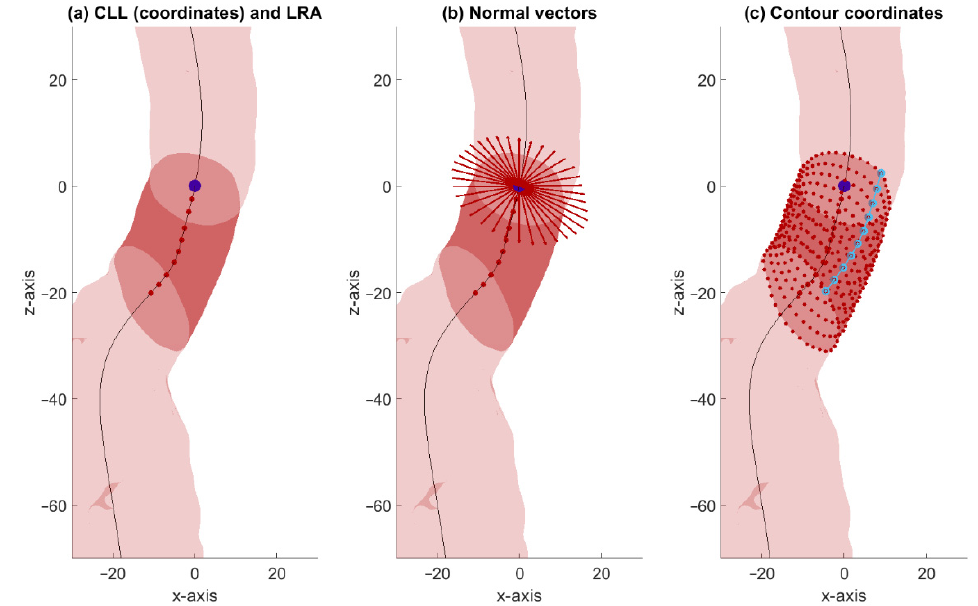
Figure 1. Visualization of the parameterization of one patient. The surface of the aortic lumen is visible in light red, and the surface of the aortic neck is visible in dark red. ( a ) The CLL (black line), ten equidistantly spaced contour points on the CLL (red dots), and the point on the CLL that corresponds to the projection of the origin of the lowest renal artery coordinate (blue dot); ( b ) for the first CLL coordinate, 36 normal vectors are displayed; ( c ) the 360 intersections of the normal vectors with the mesh are displayed as red dots. Ten coordinates (light blue dots) at the same orientation were longitudinally rearranged at equal distance (light blue line).